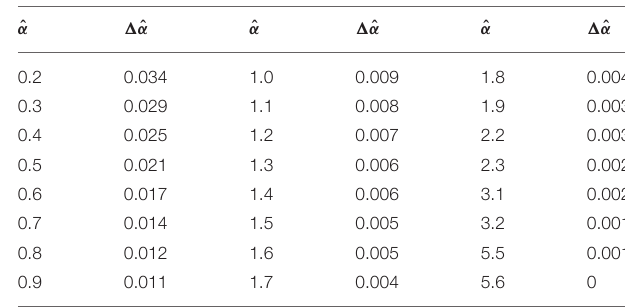
TABLE 1 | Errors for correcting the α